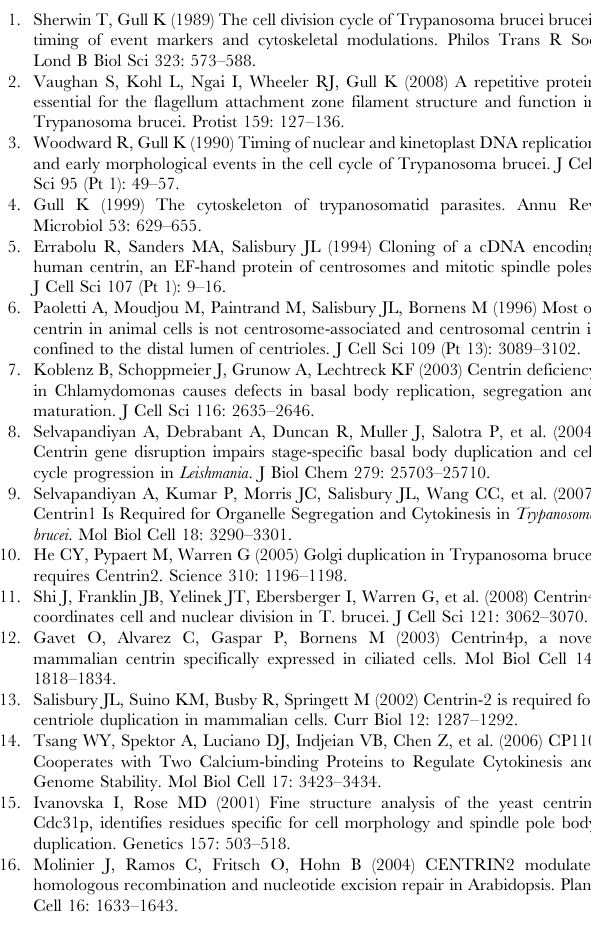
day 3 after induction for TbCen2 RNAi cells and day 2 for TbCen3 RNAi cells. (TIF) Table S1 Primer sequences used in the RNAi vector construction and probes for Northern blot analysis. All sequences are described in the 5 9 to 3 9 directions. Underlined regions are the restriction sites for the enzyme XhoI in the sequences 26F and 20F and HindIII in the sequences 27R and 21R. In sequence names ‘F’ stands for forward primer and ‘R’ stands for reverse